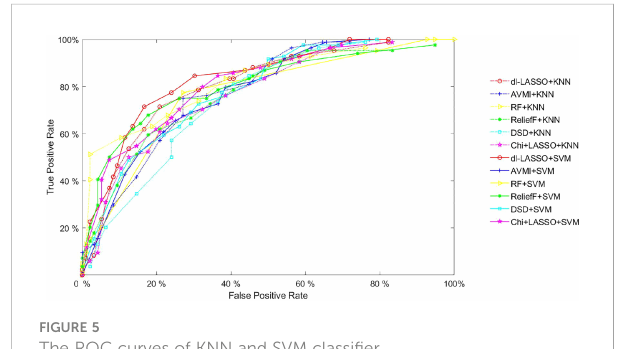
FIGURE 5 The ROC curves of KNN and SVM classi fi